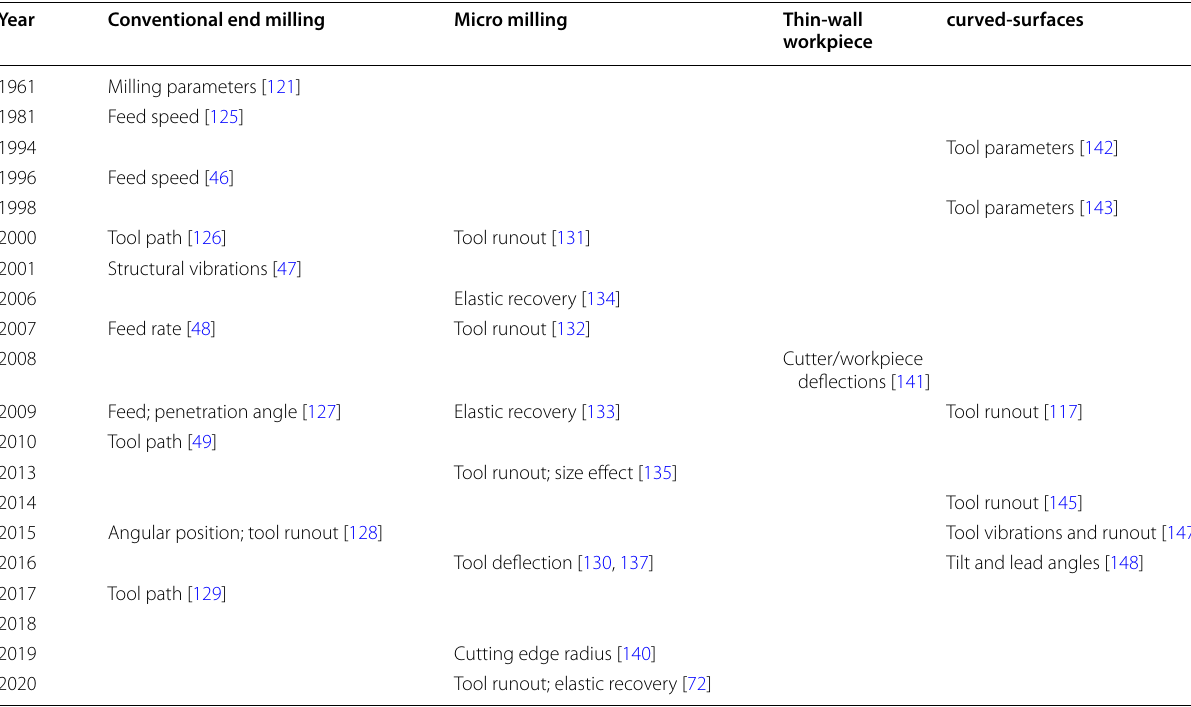
Table 4 Research literatures on cutting thickness of aerospace aluminum